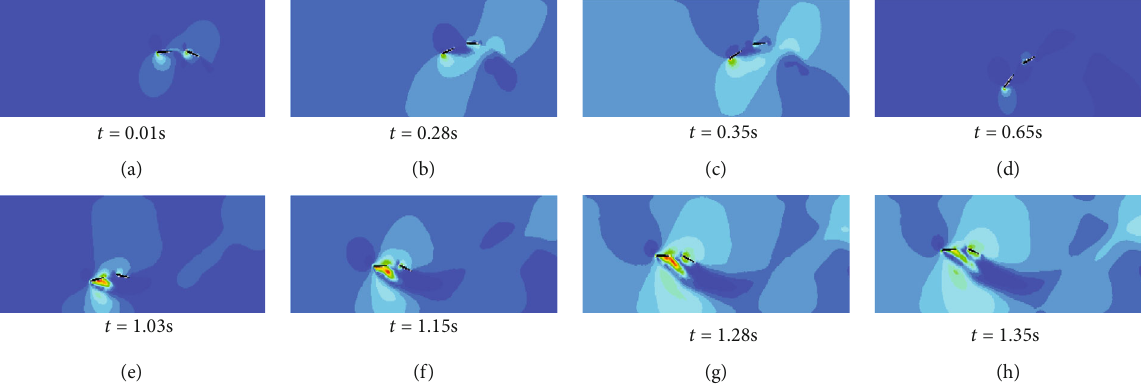
Figure 13: Vortex ’ s dissipation model pressure cloud.